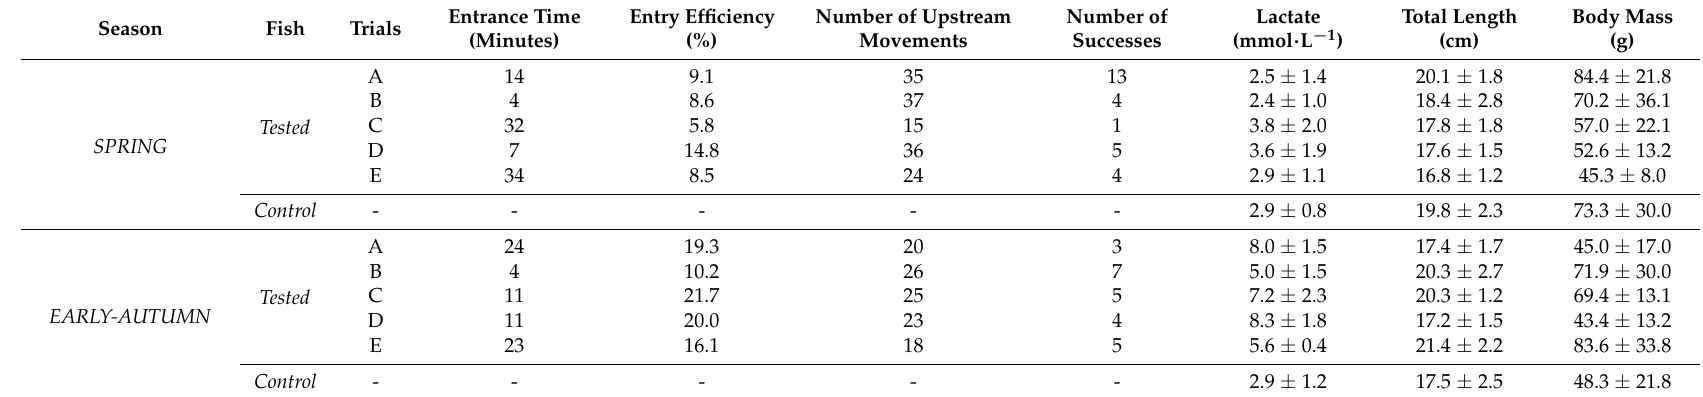
Table 1. Summary of the variables assessed in the Vertical Slot Fishway for the Iberian barbel, Luciobarbus bocagei (Steindachner, 1864), in both seasons (spring and early-autumn).